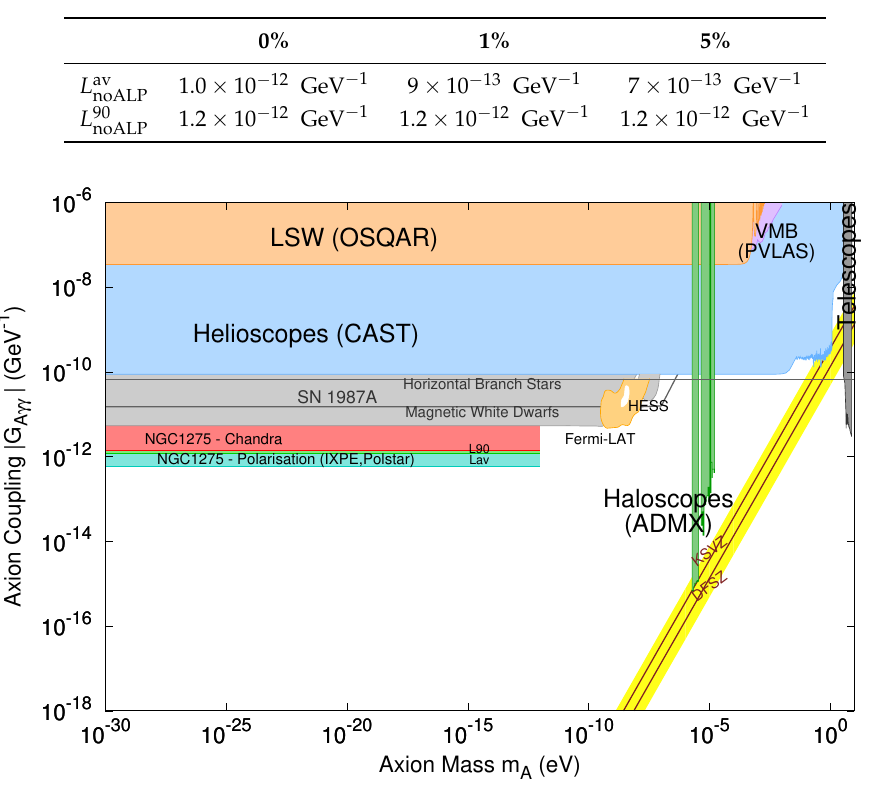
Table 2. Projected upper limits on g a γγ with Polstar. The columns correspond to different intrinsic polarisations of the AGN. The rows correspond to whether the average or 90th percentile likelihood value is used to characterize how well the no ALP model fits the simulated data.